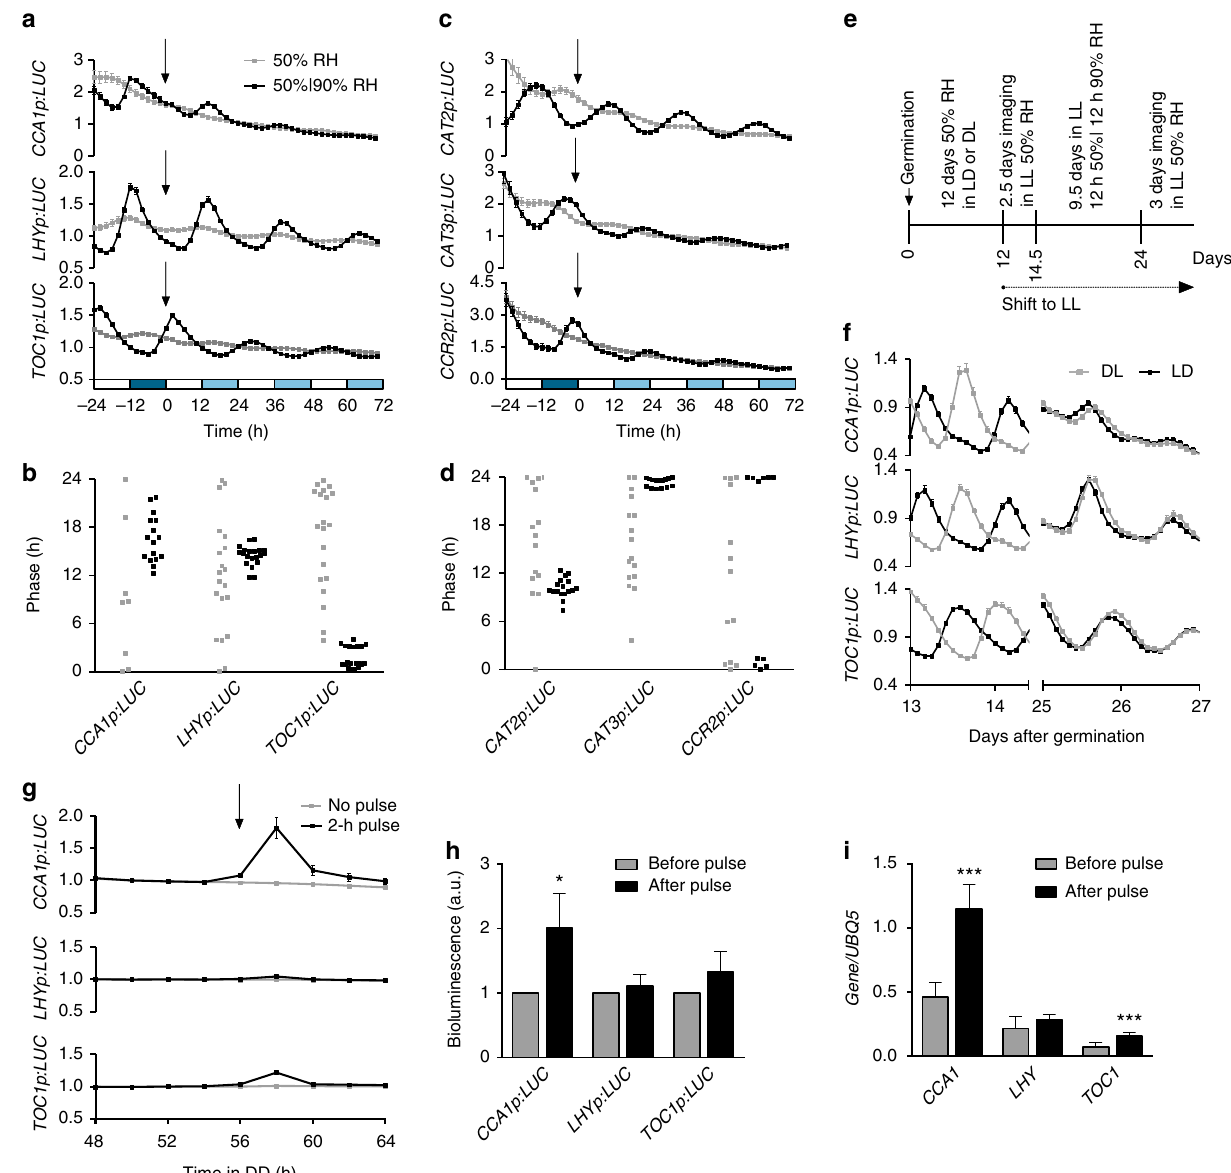
Fig. 2 Humidity oscillation entrains the circadian clock in LL. a – d Luciferase reporter activity rhythms ( a , c ) and calculated circadian phases ( b , d ) of core clock genes, CCA1 , LHY and TOC1 ( a ), and circadian clock output genes, CAT2 , CAT3 and CCR2 ( c ), in WT plants grown under LL at 22 °C with either constant 50% RH (grey) or 12 h 50%/12 h 90% RH (black). Luciferase activity was normalized to the peak value between time − 26 and − 4 h. Circadian phases were calculated by performing FFT-NLLS 62 to the data between 0 and 72 h with the period constrained between 18 and 30 h. White bars, 50% RH; dark blue bars, 90% RH; light blue bars, subjective 90% RH; black arrow, transition from entrainment conditions to free-running conditions. Data are shown as mean ± s.e.m.; n ≥ 20 plants. Relative amplitude error values of ≤ 0.7 were considered rhythmic. These experiments were repeated three times with similar results. See Supplementary Fig. 3. e Work fl ow describing the experiment of phase setting by humidity. f Luciferase reporter activity rhythms of CCA1 , LHY and TOC1 in response to conditions described in e . Plants were grown under DL (grey) or LD (black). Data are shown as mean ± s.e.m.; n ≥ 12 plants. g Luciferase reporter activity rhythms of CCA1p : LUC , LHYp:LUC and TOC1p:LUC in response to a 2-h pulse of 90% RH at 54 h in DD. Luciferase reporter activity was normalized to the average value between 48 and 52 h. DD constant dark; black arrow, start of the 2-h 90% RH pulse. Data are shown as mean ± s.e.m.; n ≥ 8 plants. The experiment was repeated three times with similar results. h , i Luciferase activities ( h ) and endogenous clock gene expression ( i ) in response to a 2-h pulse of 90% RH at 54 h in DD. Data are shown as mean ± s.d.; t -test, * p < 0.05, *** p <